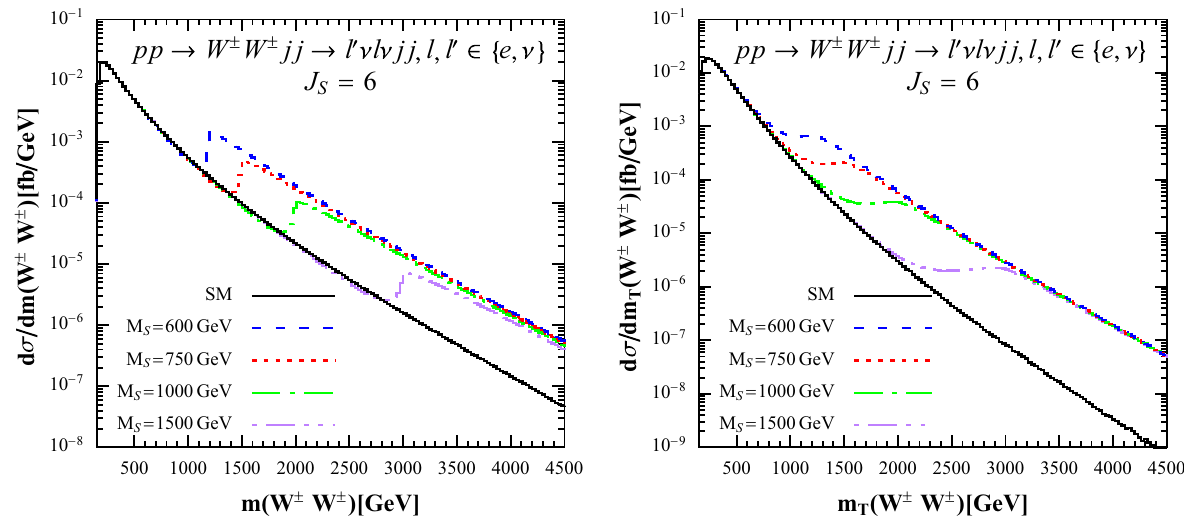
Fig. 12 Invariant mass distribution of the W pair and transverse mass distribution of the lepton-neutrino system in same-sign WW events for the contribution of a single J S = 6 multiplet, but for a range of scalar masses, M S stant 100 GeV bin width, the central panel uses the binning employed in Refs. [46,47], and the ratio to the SM is shown in the right panel. In contrast to the same-sign W W and W ± Z final states the interference with the SM is constructive (see right panel) and the peak itself is more pronounced (see left panel). We emphasize again that a direct comparison to